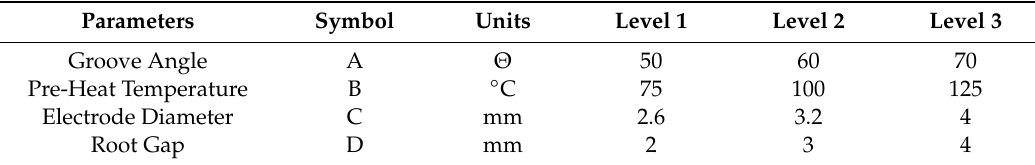
Table 3. Welding parameters and